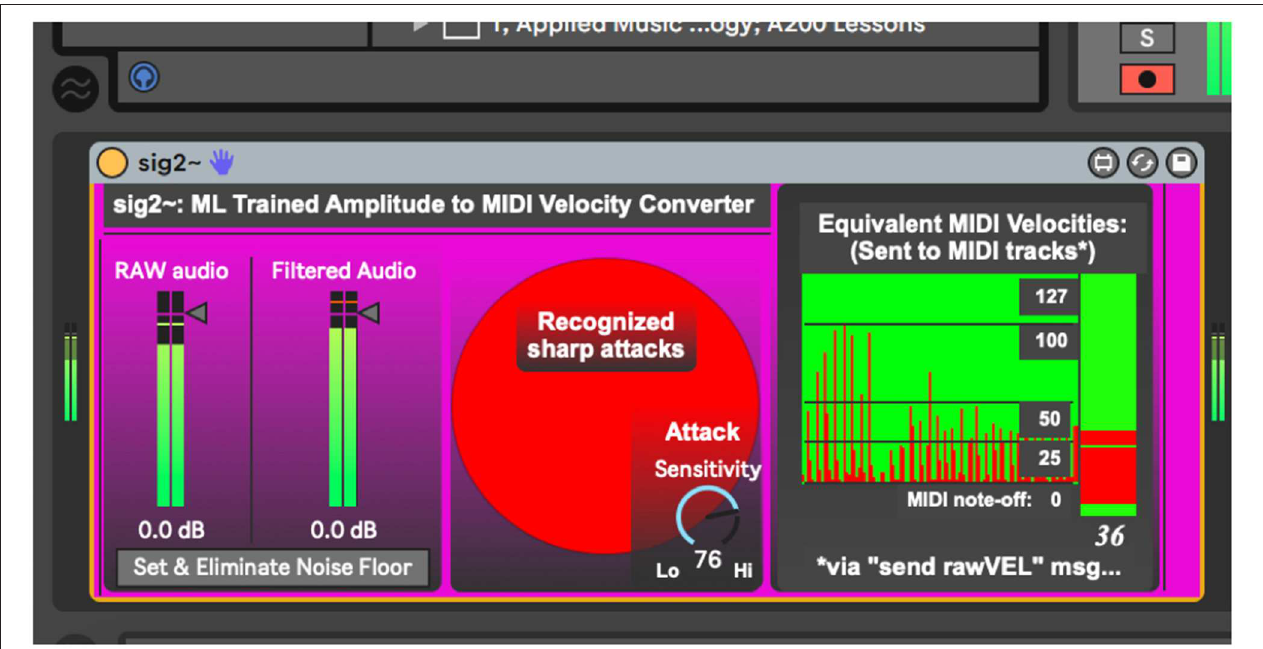
FIGURE 3 | Dyna.amxd, a program that translates MIDI velocities into various dynamic representation systems.